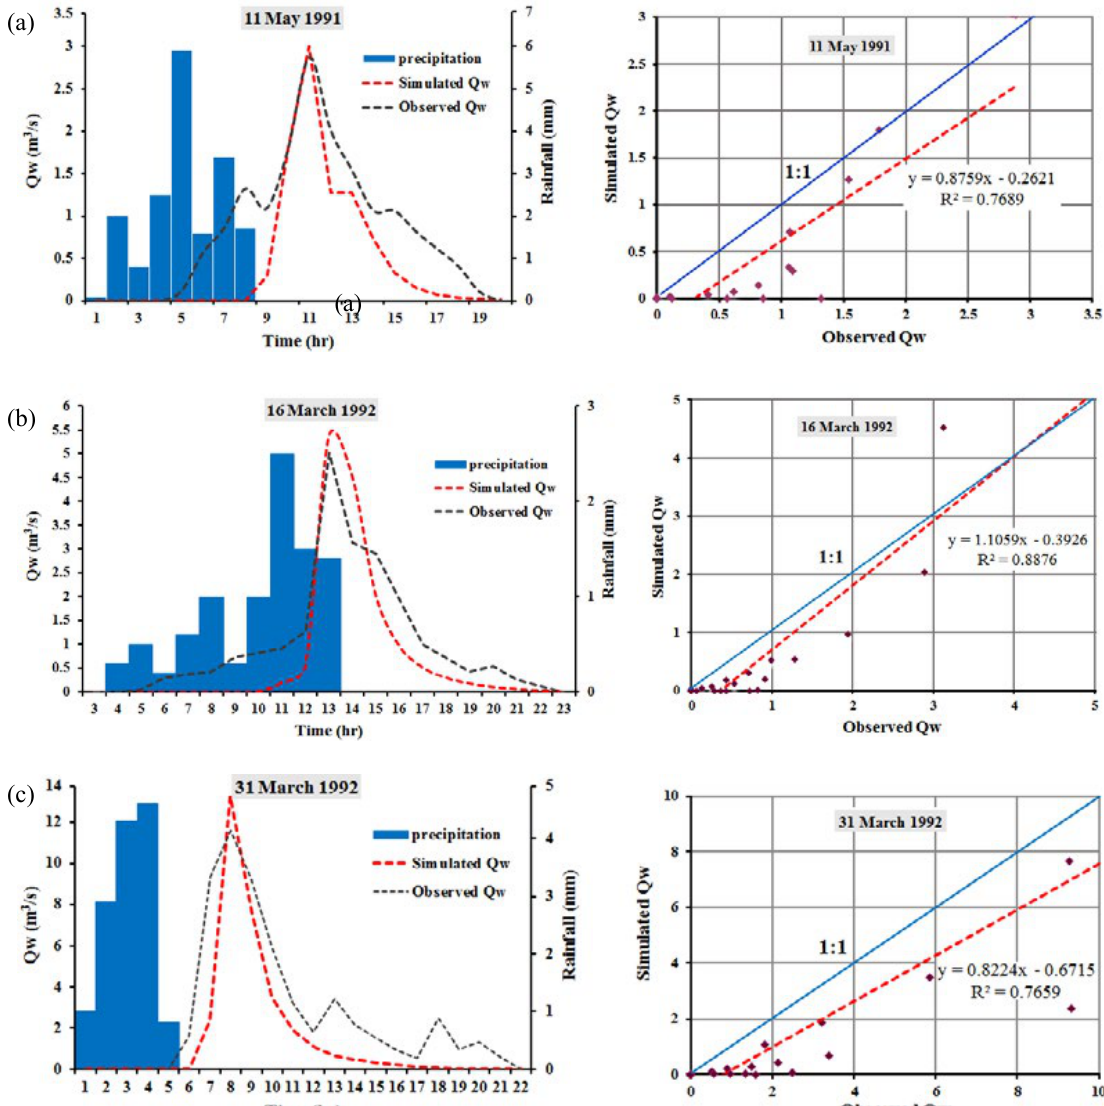
Fig. 4: Simulated vs. observed hydrographs during calibration process based on: a) storm event #1; b) storm event #2 and c) storm event